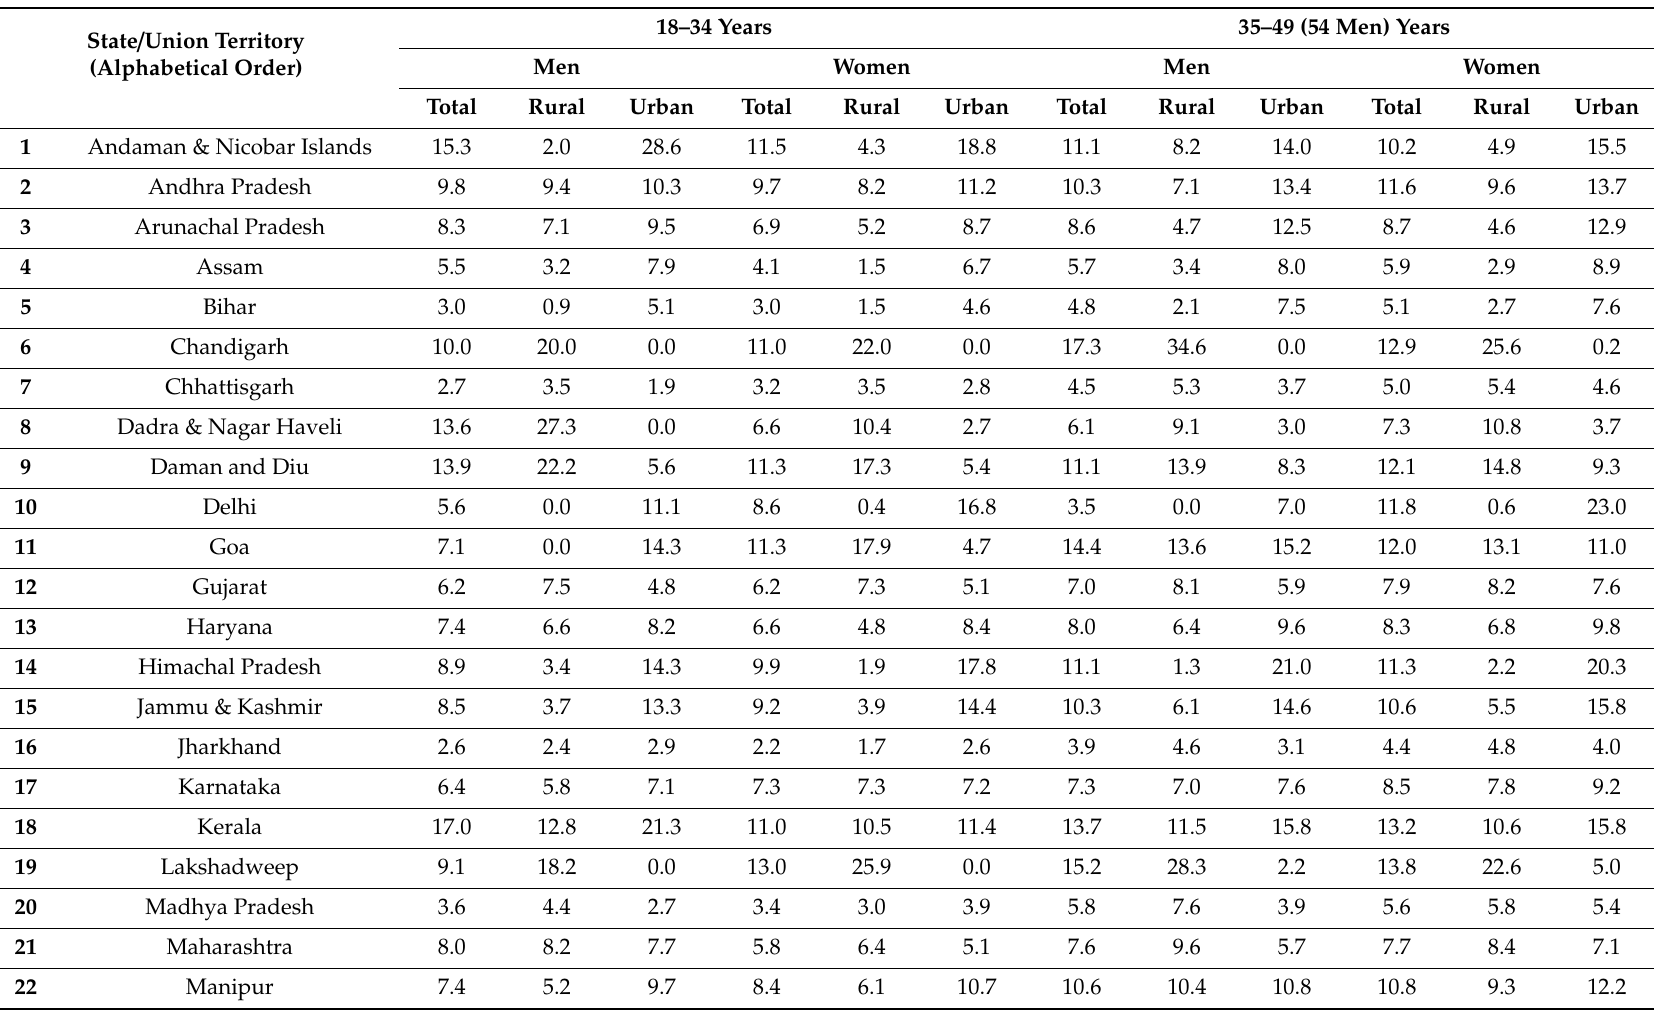
Table 2. The prevalence of overweight among adults according to age group, sex, and type of residence for each state and union territory. State / Union